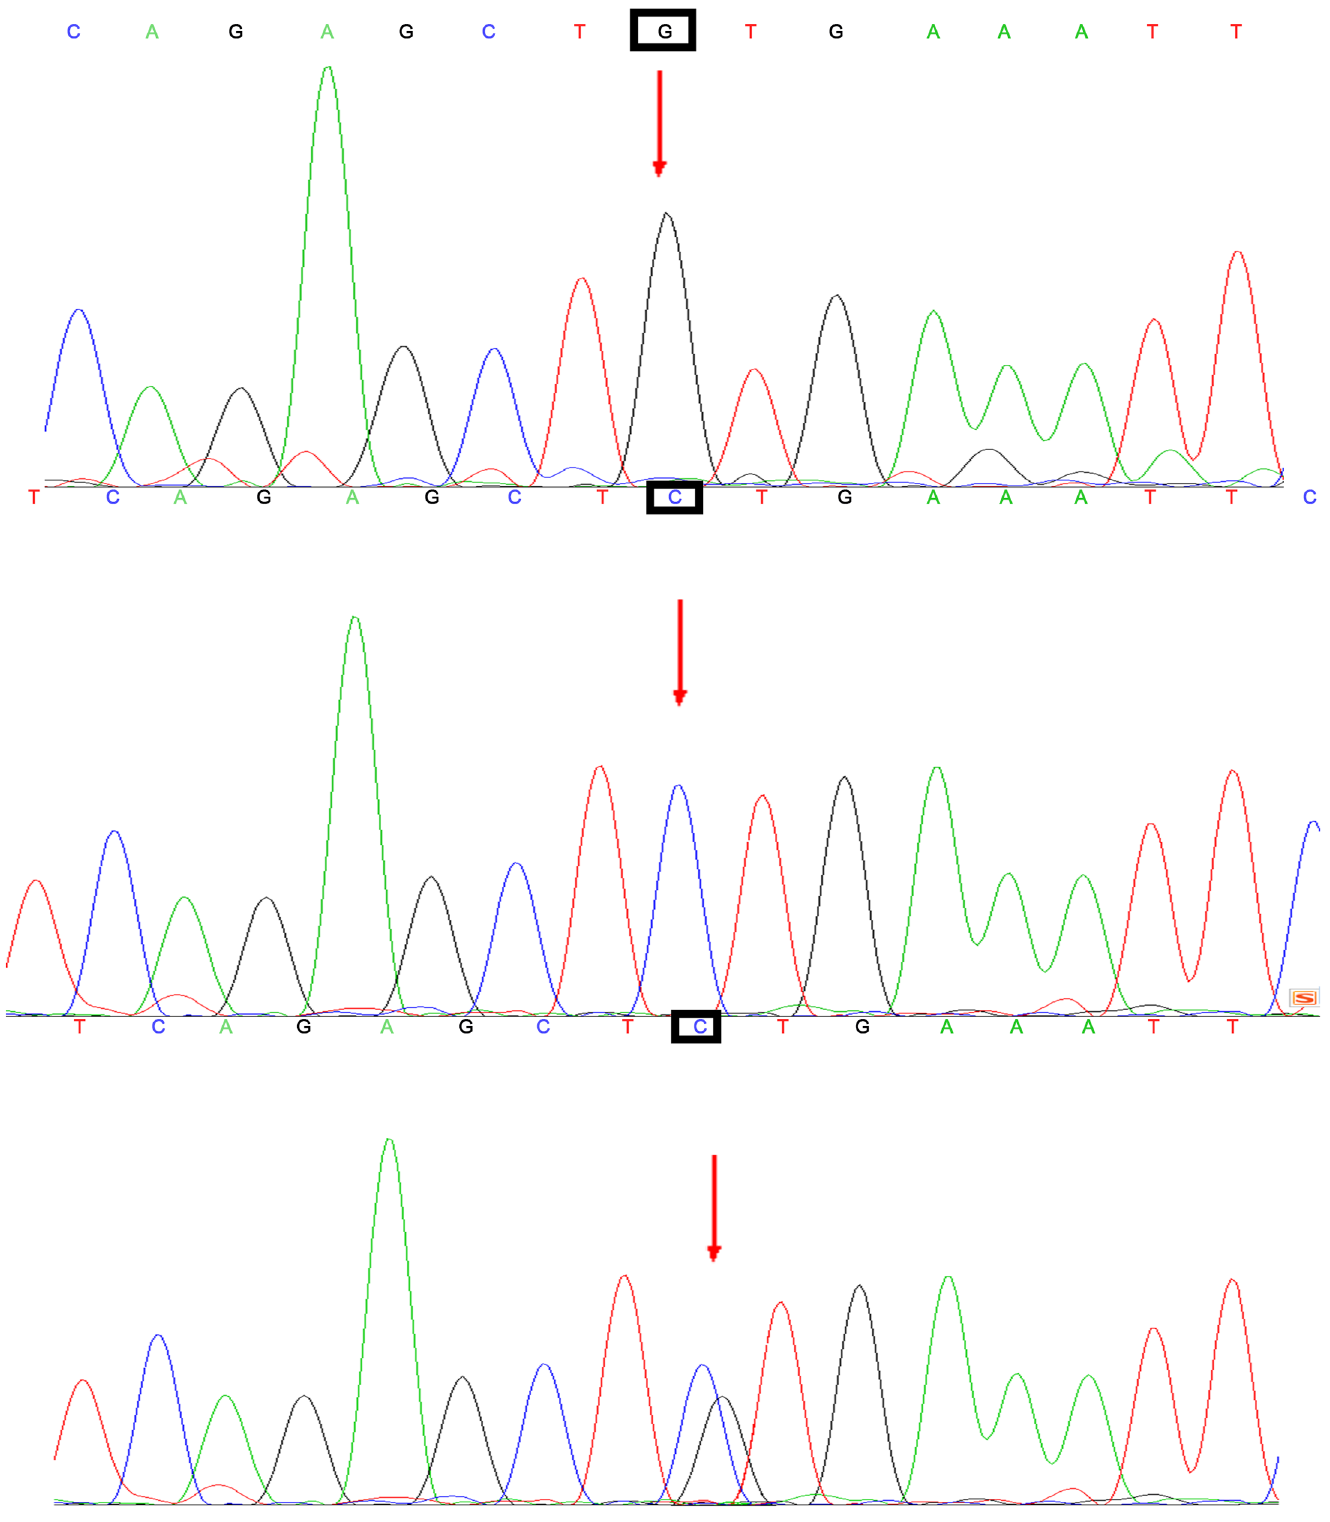
Fig 2. Representative sequencing results of rs2910164.